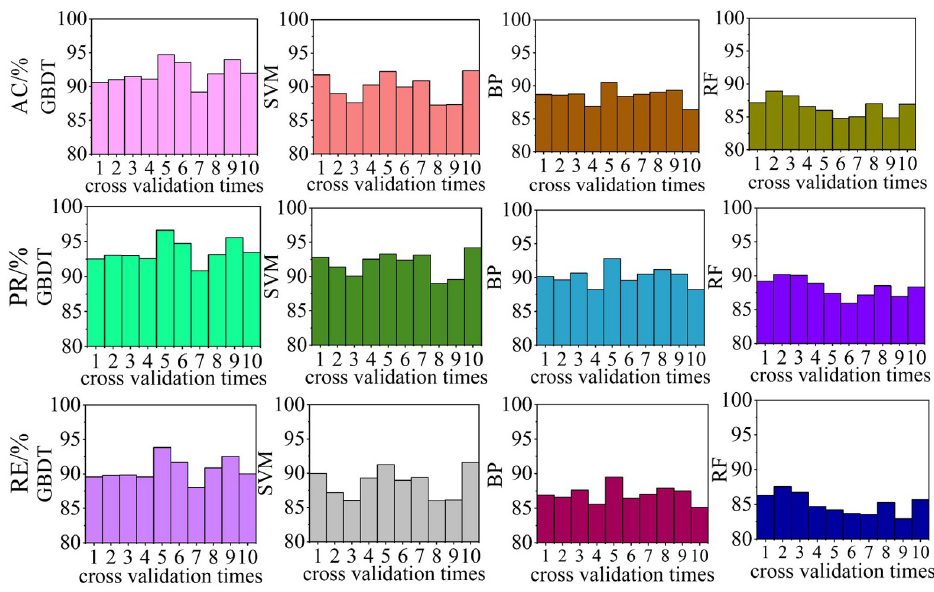
Fig 23. Disturbance recognition performance comparison for algorithms with different classification models.